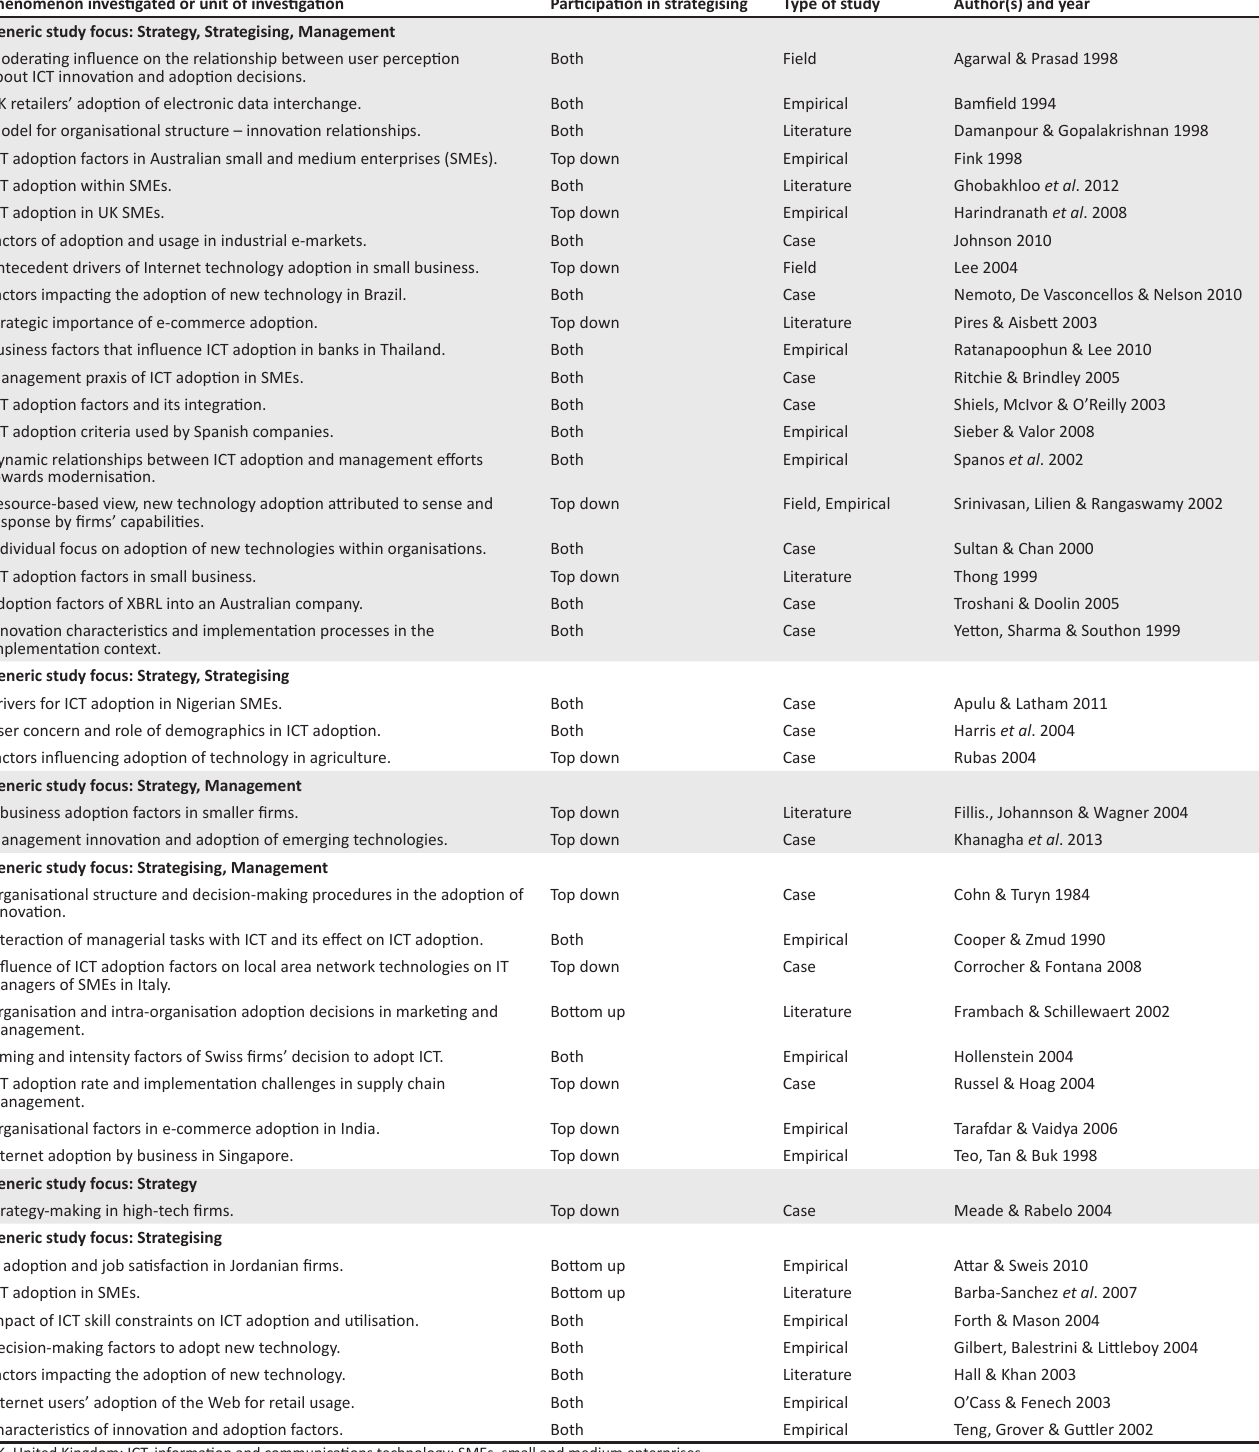
TABLE 2: Literature studies on ICT adoption. Phenomenon investigated or unit of investigation Participation in